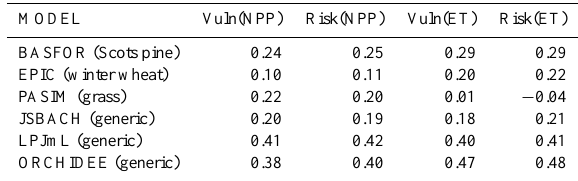
Table 4. Correlations of vulnerabilities and risks calculated for NDVI with those calculated for model outputs of NPP and of ET at the European scale (where n is model-specific, see Table 1). All val- ues are averages for April–September over multiple years